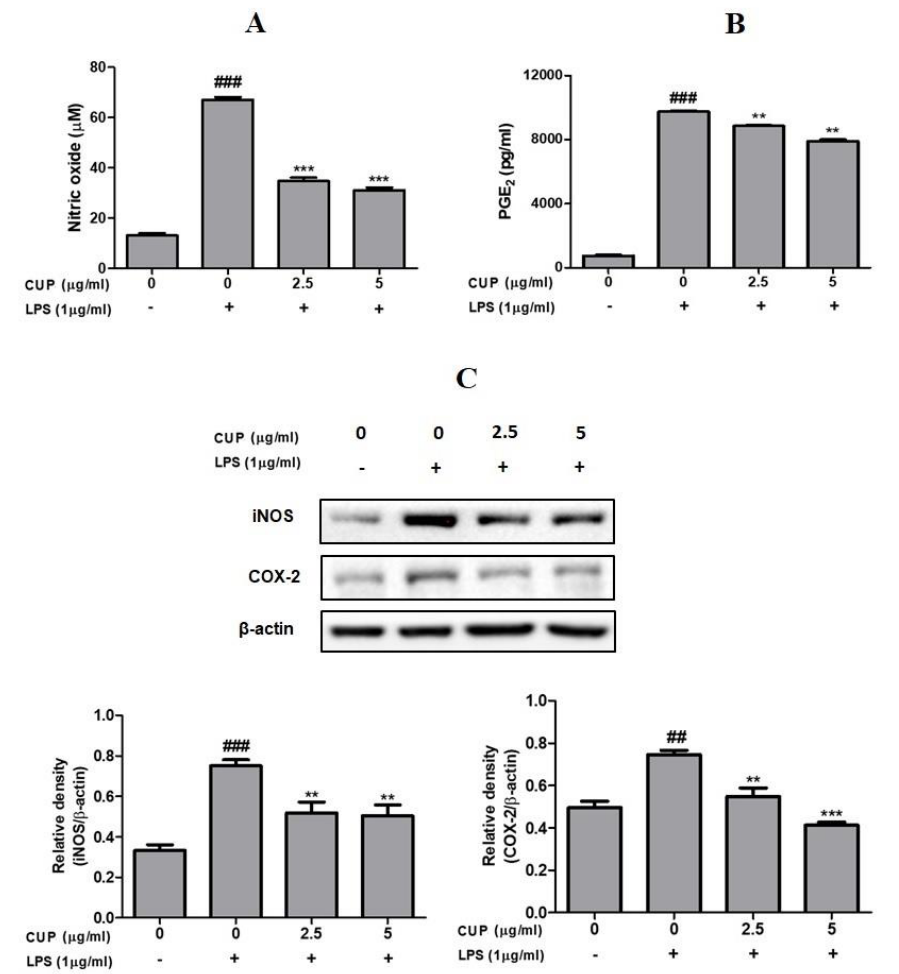
Figure 4. Effect of Citrus unshiu peel (CUP) flavonoids on ( A ) nitric oxide (NO) and ( B ) prostaglandin E2 (PGE 2 ) production and (C) iNOS and COX-2 protein expression levels in LPS-stimulated RAW264.7 cells. NO and PGE 2 production and iNOS and COX-2 expression levels measured in cells treated at different concentrations of CUP flavonoids (0, 2.5 and 5 µ g/mL) for 24 h, with or without 1 h pre-incubation of lipopolysaccharide (LPS) (1 µ g/mL). Note: Data are the mean ± SEM of exper- iments in triplicate (n = 3). ## p < 0.01 vs. un treated group; ### p < 0.001 vs. untreated group; ** p < 0.01 and *** p < 0.001 vs. LPS-alone treated group. Relative expression of iNOS and COX-2 was measured and β -actin was used as internal control. Bands expressed in Western blots were measured by den- sitometry.